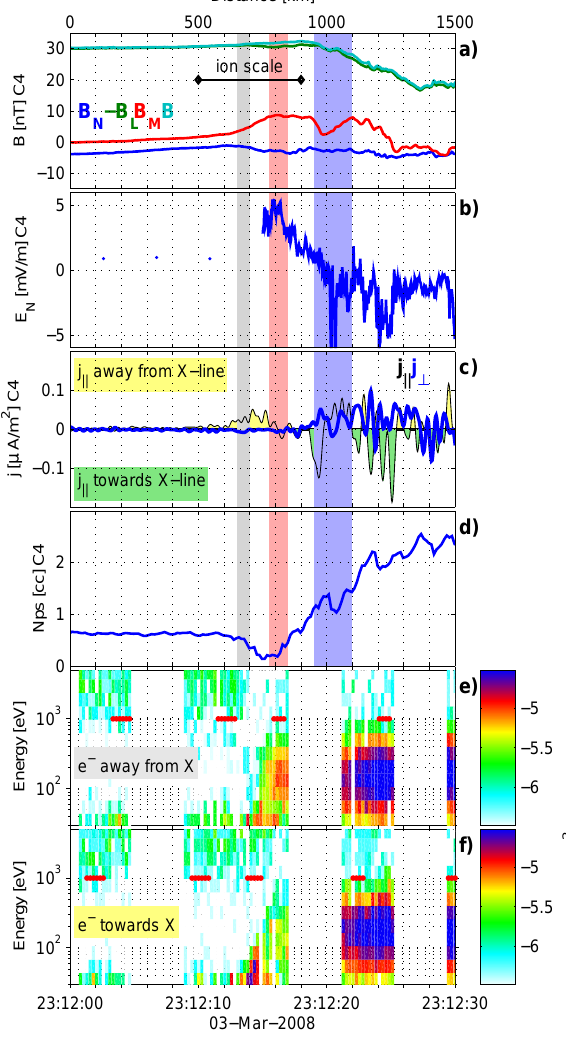
Fig. 3. Cluster C4 observations of a crossing of boundaries on the magnetospheric side during reconnection at the magnetopause. Boundaries are color marked as separatrix (gray), Alfv´en edge (pink) and ion edge (blue). Panels show: (a) magnetic field, (b) electric field, before 23:12:14UT the electric field is contam- inated due to the presence of cold magnetospheric ions, but elec- tric field values shown (dots) are the ones inferred from ion ve- locity, (c) parallel and perpendicular currents, (d) plasma density derived from the satellite potential, (e) electron energy spectrogram of electrons moving parallel to magnetic field (away from X-line), (f) electron energy spectrogram of electrons moving antiparallel to the magnetic field. On magnetospheric side ion inertial length is ∼ 360km and gyroradius of hot 10keV ions is ∼ 480km. On the magnetosheath side of boundaries the inertial length is ∼ 130km and gyroradius for magnetosheath ∼ 1keV ions is ∼